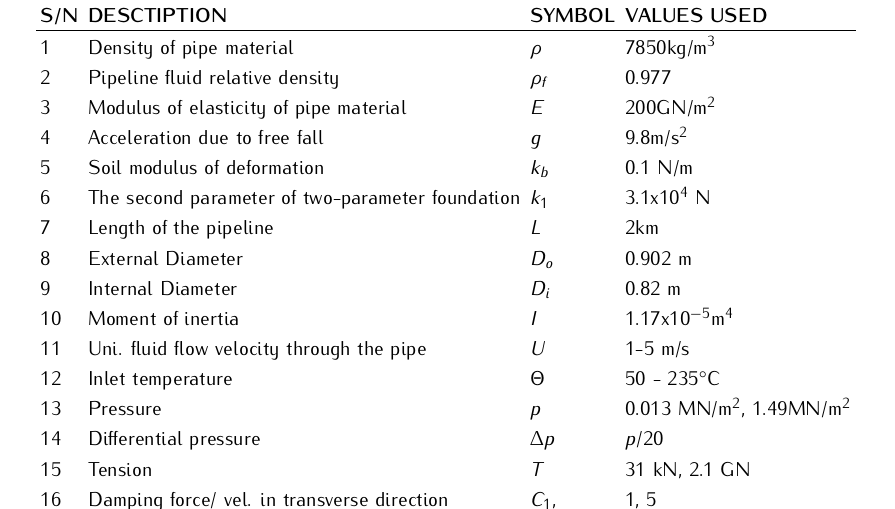
Table 1. Parametric Values Used For Simulation